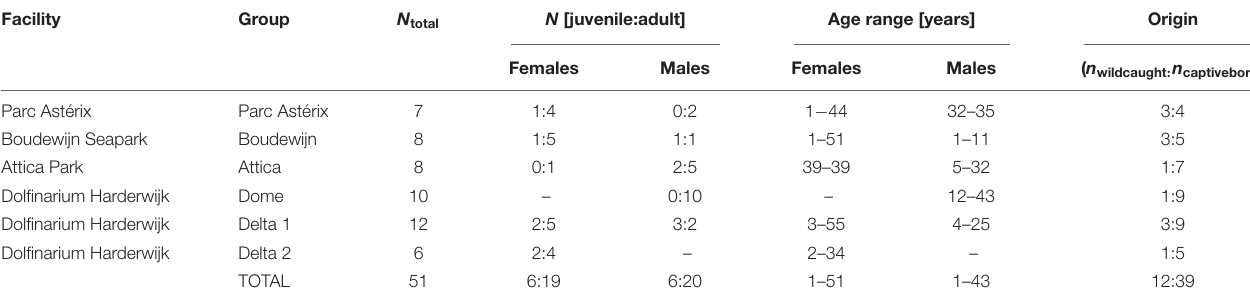
TABLE 1 | Age and sex characteristics of bottlenose dolphin study population.